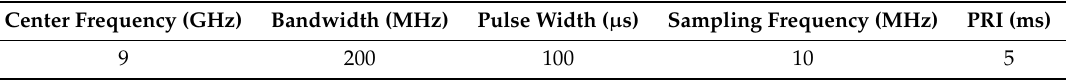
Table 2. Simulation parameters of the evaluation of the proposed CCAE method. Center Frequency